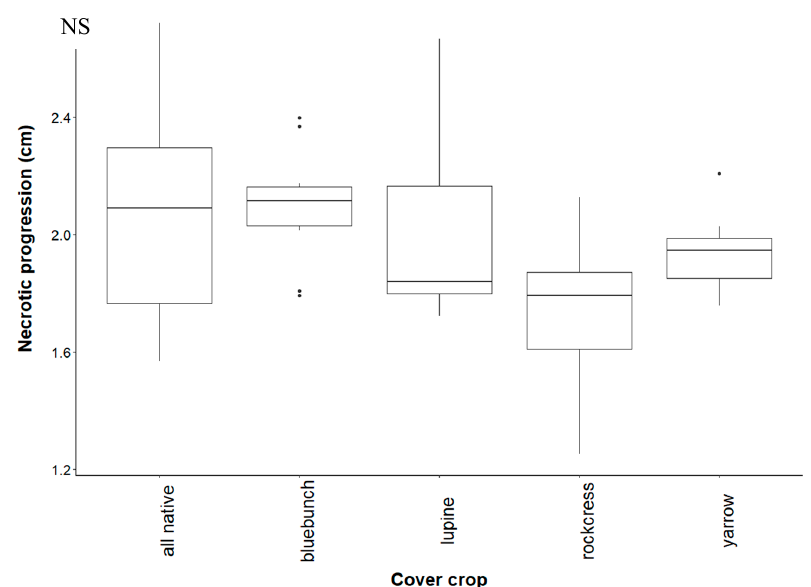
Figure A2. Progression of necrotic damage in grapevines grown in soil conditioned by native cover crops. The extent of necrosis is measured from the basal end. Treatments are all plants grown together (“all native”), bluebunch wheatgrass (“bluebunch”), silky lupine (“lupine”), Holboell’s rockcress (“rockcress”), and white yarrow (“yarrow”). Boxplots show the first and third quartile, median (middle line), range (whiskers), and circles (outliers). Data were normalized by taking the natural logarithm plus 1 (log1p) of necrotic progression values. There was no significant di ff erence (NS) between cover crop treatments.